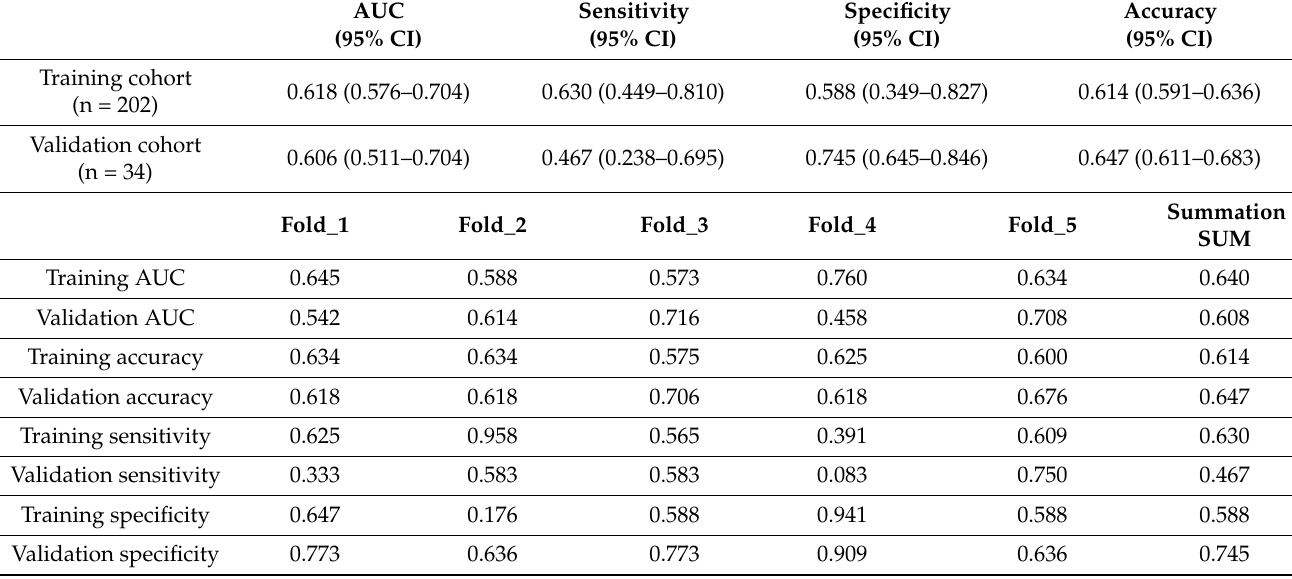
Table A2. Classification indices with traditional deep learning (ResNet) without UMAP or metric leaning.